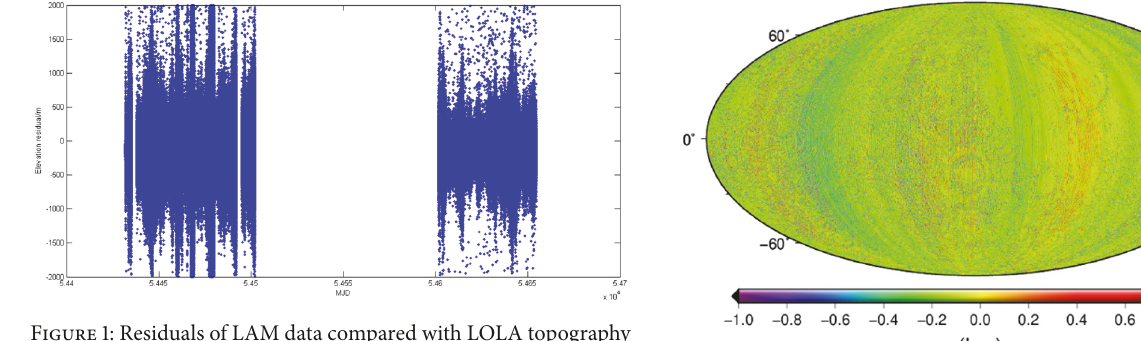
Figure 1: Residuals of LAM data compared with LOLA topography model.